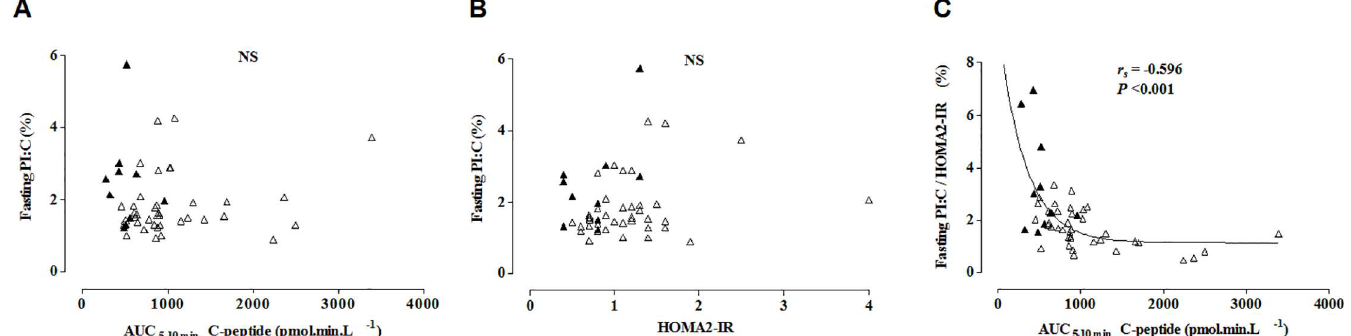
Fig 2. RelationbetweenfastingPI:C and AUC 5-10min C-peptide (A), fastingPI:C and HOMA2-IR (B) and fastingPI:C correctedfor HOMA2-IR and AUC 5-10min C-peptide(C) in relativesat highautoantibody-inferredrisk (HR) (IA-2A + or ZnT8A + plus (cid:21) 1 otherautoantibody) (9). Filled triangles = progressors within2 years (n = 10), opentriangles= slow-/non-progressors (n = 39). AUC 5-10min C-peptide: first-phaseAUC C-peptide releaseduringhyperglycemic clamptest (min 5–10);HOMA2-IR: homeostatic modelassessment for insulinresistance; r s : Spearman’s rank correlationcoefficient; NS: not significant doi:10.1371/journal.pone.0166702.g002 achieved values for AUC under the ROC-curve (AUC-ROC), diagnostic accuracy, and AIC